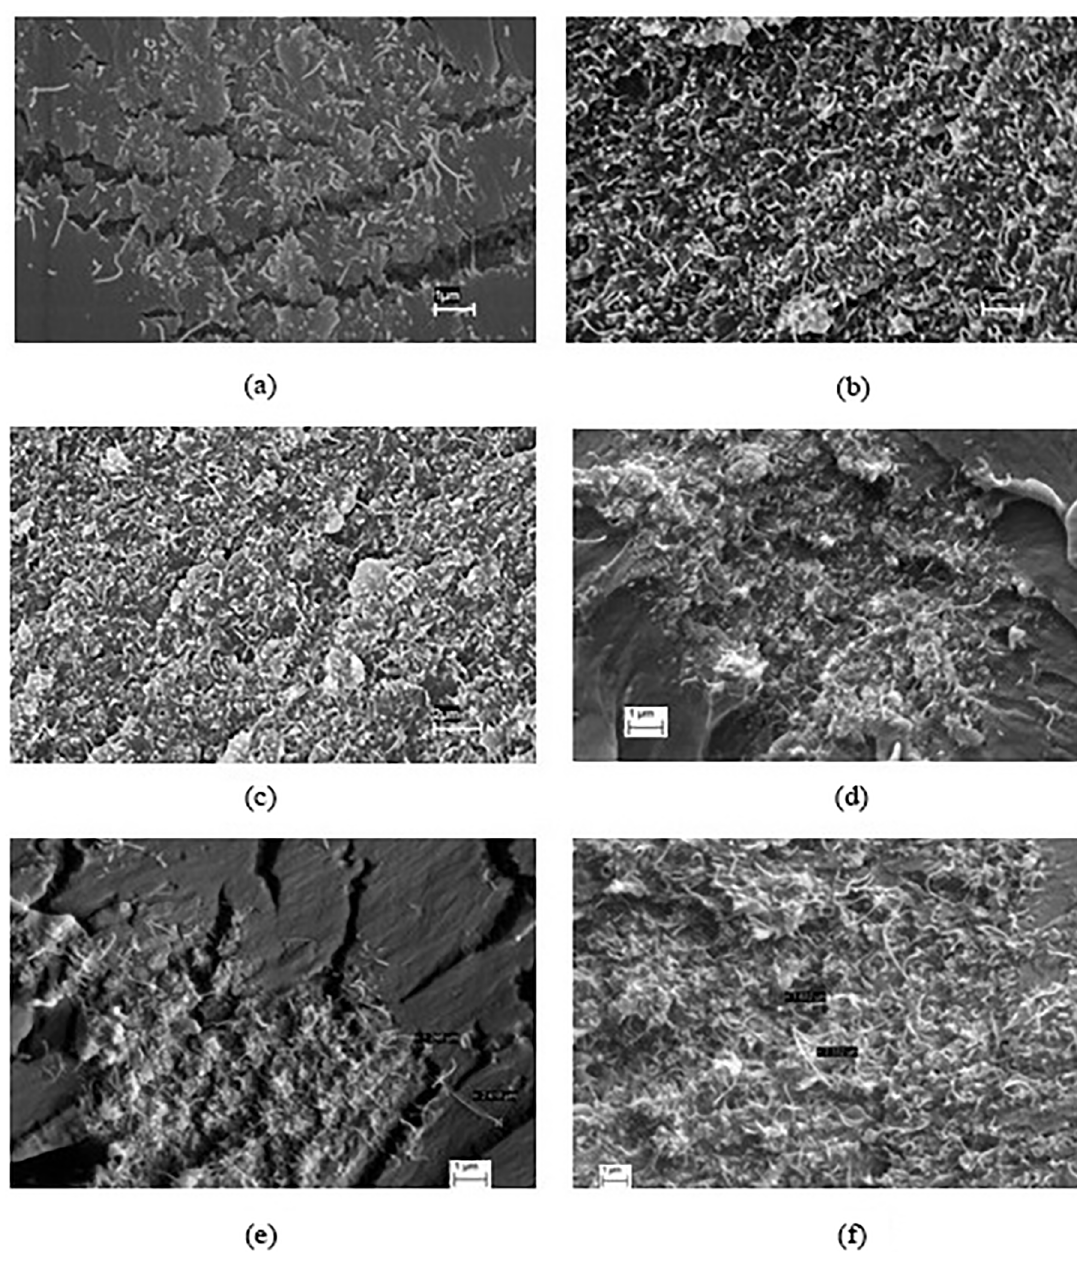
Figure 4. SEM of CNT/epoxy resin composites. CNT-B contents (wt%): (a) 0.1, (b) 0.5, (c) 1.0 and CNT-K (wt%): (d) 0.1, (e) 0.5, (f) 1.0